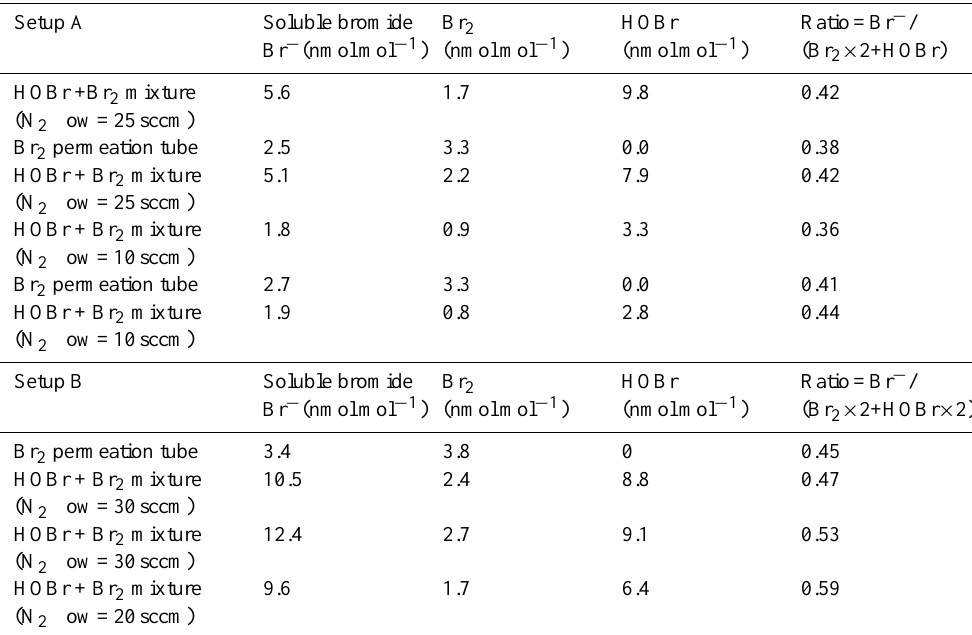
Table 1. The response of the MC to Br 2 and HOBr from setup A and B.